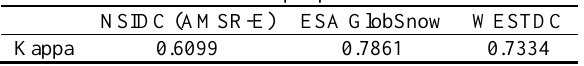
Table 2. The Confusion matrix for remote sensing image